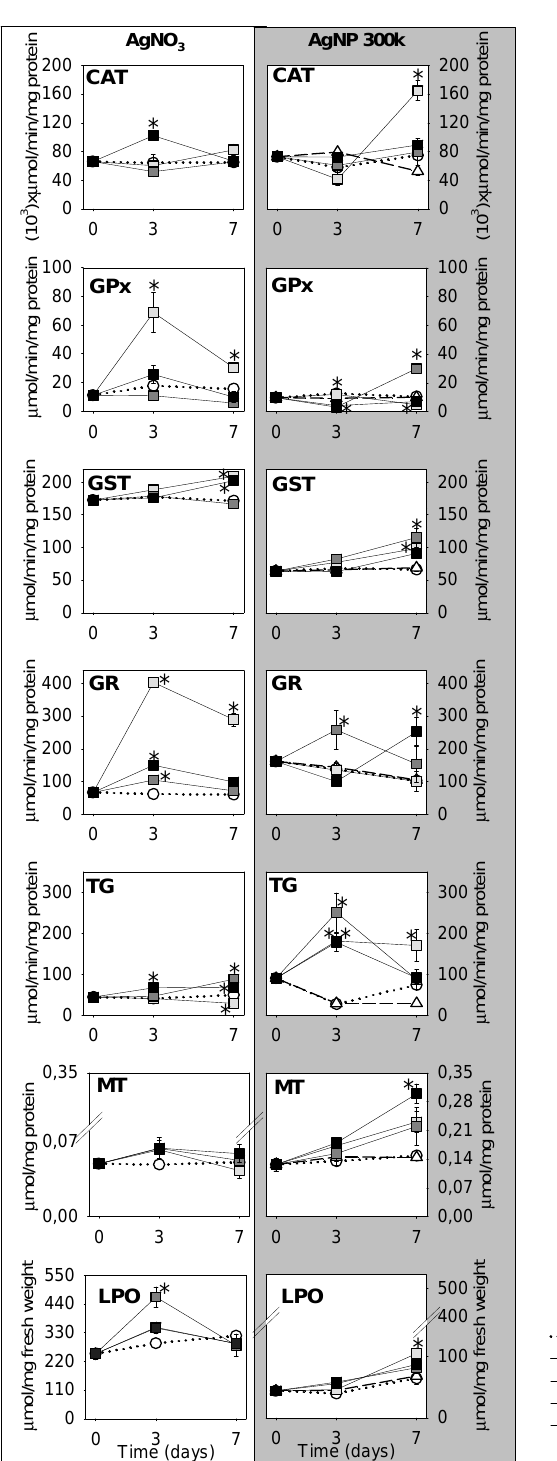
Figure 1. Biochemical analyses results from Enchytraeus crypticus exposed to Ag NM300K [60 (EC20), 170 (EC50) and 225 (EC80) mg Ag/kg soil] and AgNO 3 [45 (EC20), 60 (EC50) and 96 (EC80) mg Ag/kg soil], as sampled at 0, 3–7 days, in terms of catalase (CAT), glutathione peroxidase (GPx), glutathione S-transferase (GST), glutathione reductase (GR), total glutathione (TG), metallothionein (MT) and lipid peroxidation (LPO). Values are expressed as mean ± standard error (n = 5). * ( p < 0.05, Dunnetts’ test) for differences between control and